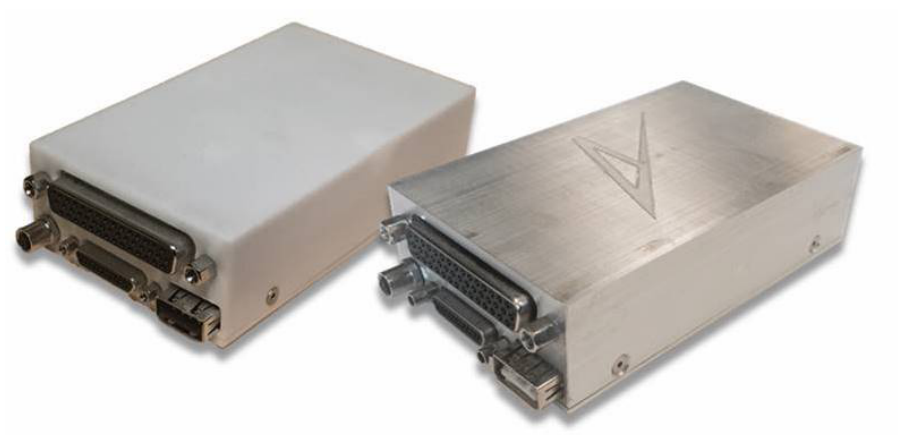
Figure 4. The commercialized Al Volo FDAQ and FC+DAQ data acquisition and flight control